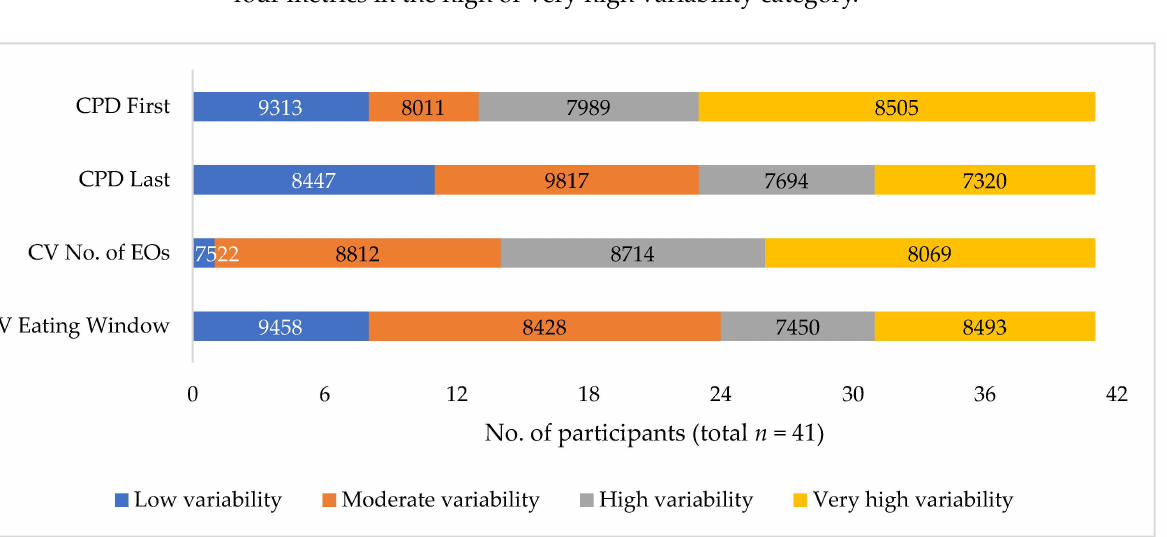
Figure 2. Stacked bar chart showing the number of participants that fall into the low, moderate, high, and very high intra-individual variability categories for each metric. Numbers within each category represent the average daily energy intake (kJ) for participants in that category. CPD First: Composite Phase Deviation of the first eating occasion for each participant over the three days of data collection. CPD Last: Composite Phase Deviation of the last eating occasion for each participant over the three days of data collection. CV No. of EOs: Coefficient of variation for the total daily number of eating occasions for each participant over the three days of data collection. CV Eating Window: Coefficient of variation for the daily eating window for each participant over the three days of data